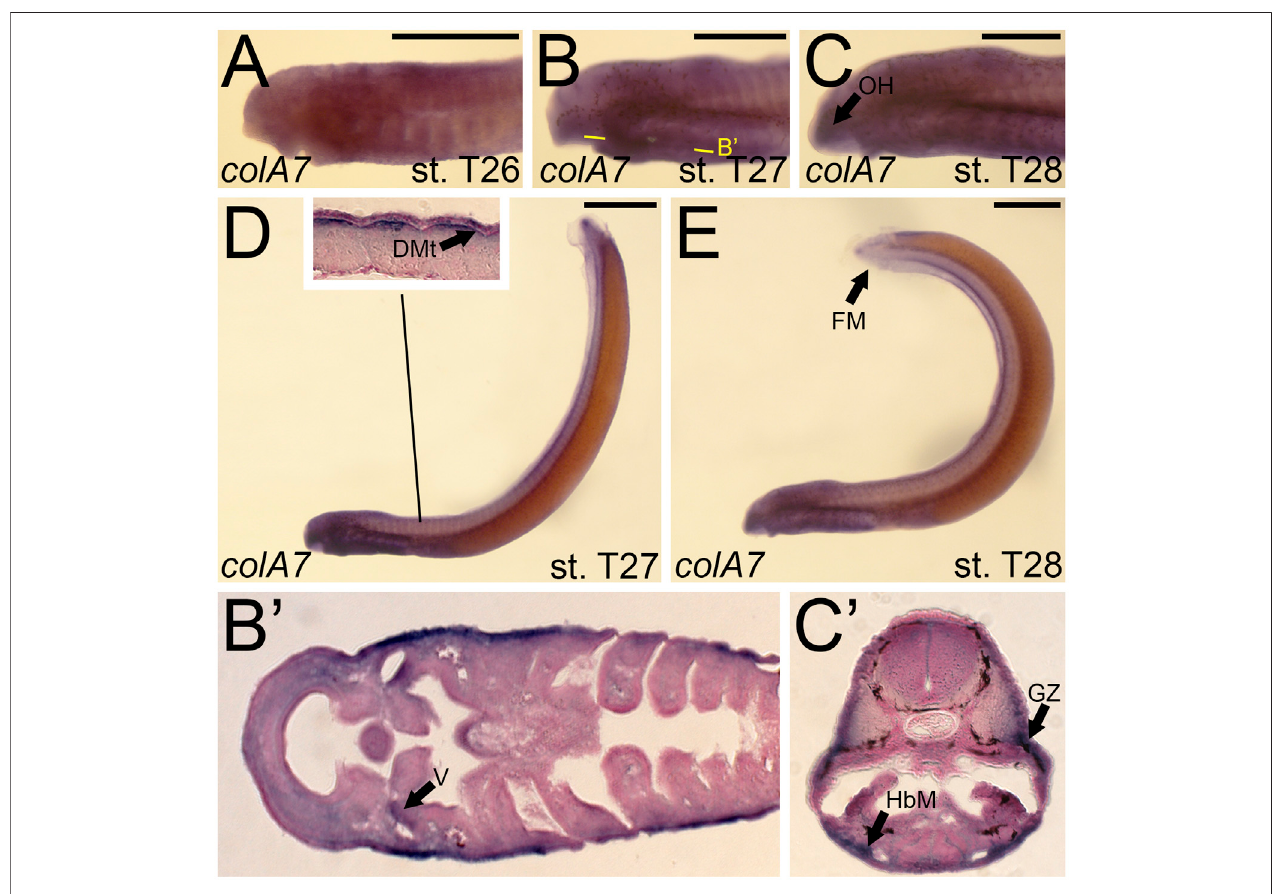
FIGURE 8 | Expression of colA7 in larval lamprey. All scale bars are approximately 500 μ m. (A) colA7 expression was weakly detected throughout the skin. (B,D) colA7 expression wasin the medial velum aswell asthe dermomyotome. (C,E) colA7 expression wasin themesenchyme of the fi n foldand oralhood, the growth zone, and the hypobranchial musculature. Keywords: DMt: dermomyotome; HbM: hypobranchial musculature; GZ: growth zone; OH: oral hood; V: velum.